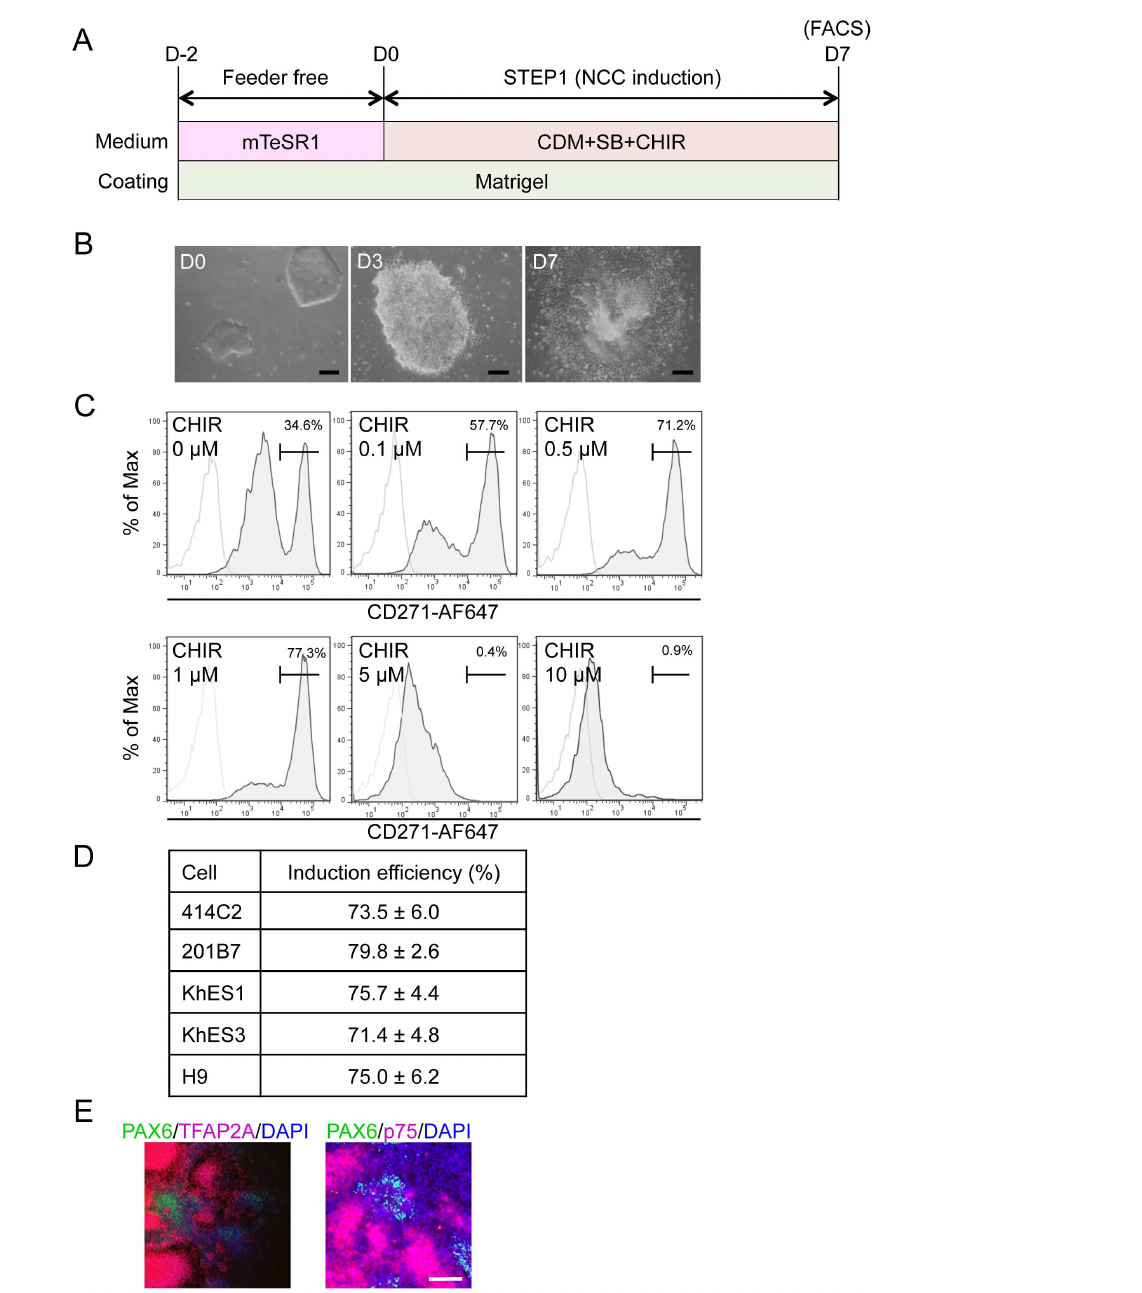
Figure 1. Induction of p75 high cells from hPSCs. A) Schematic representation of the protocol. B) Morphology of colonies during the induction. Phase contrast images were taken on days 0, 3, and 7. Scale bar, 200 m m. C) The fraction of p75-positive cells in 201B7 cells was treated with SB431542 (SB) (10 m M) and CHIR99021 (CHIR) (indicated concentration) for seven days, stained with an anti-p75 antibody, and analyzed by FACS. D) Fraction of the p75 high population induced by SB (10 m M) and CHIR (1 m M) from hESCs (KhES1, KhES3, H9) and hiPSCs (414C2, 201B7). Average ¡ SD. N 5 3, biological triplicate. E) Immunocytochemical analyses of colonies on day 7 (201B7). Cells were stained with antibodies against PAX6, TFAP2A, and p75. Scale bar, 100 m m.